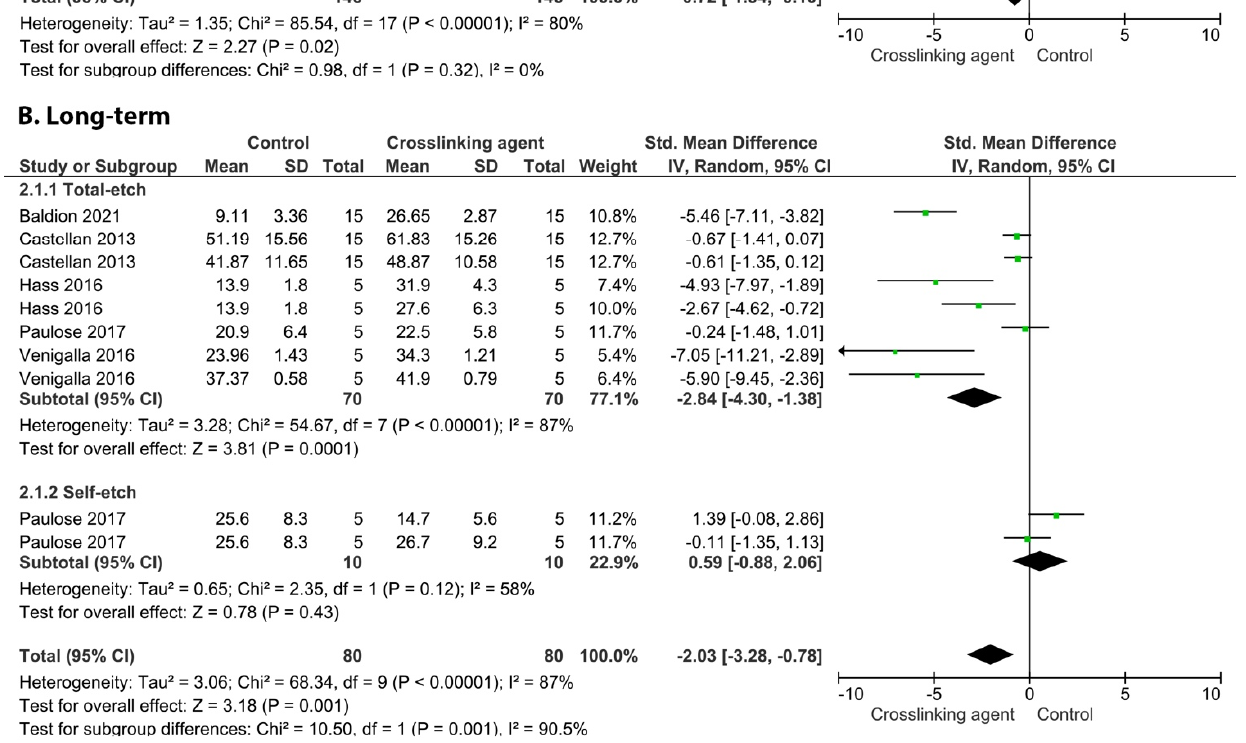
Figure 8. Forest plot of the immediate ( A ) and long-term ( B ) bond strength comparison between the proanthocyanidins crosslinking agent and the control according to the adhesive used [17,81,83,89,92,105,108,110,112,123].